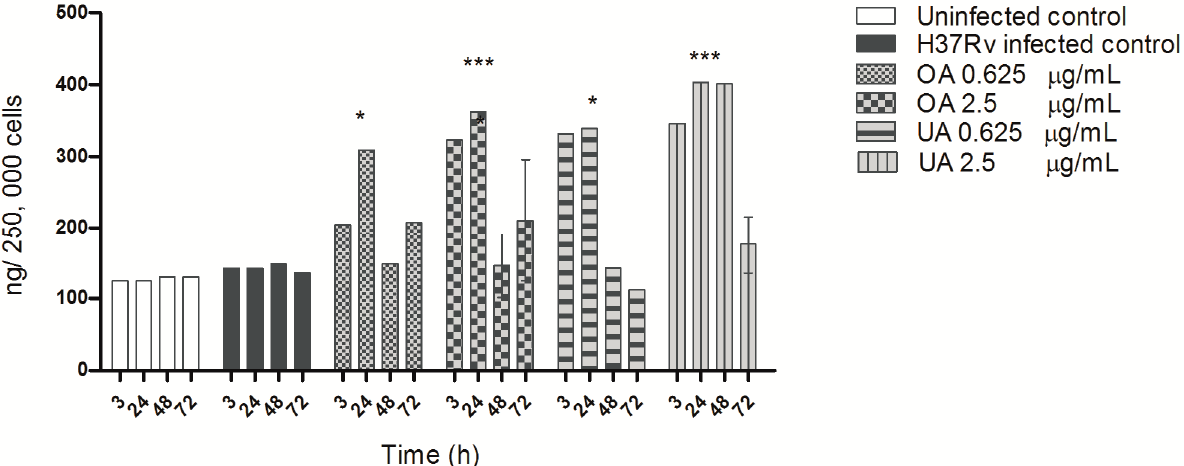
Figure 4. Nitric oxide production by J774 A.1 cells infected with M. tuberculosis and treated with triterpenes. J774 A.1 macrophages were infected with H37Rv and treated with different concentrations of triterpenes OA and UA. Nitric oxide production was determined by nitrite quantification with Griess reagent at 3, 24, 48 and 72 h post-infection. Values represent means and standard deviations from three experiments. Statistically significant differences (*** p < 0.001 and * p < 0.5) shown are, when infected and treated cells (OA, UA) were compared with infected cells (H37Rv infected control). No statistically significant differences were observed when non-infected cells (Uninfected control) were compared with infected cells